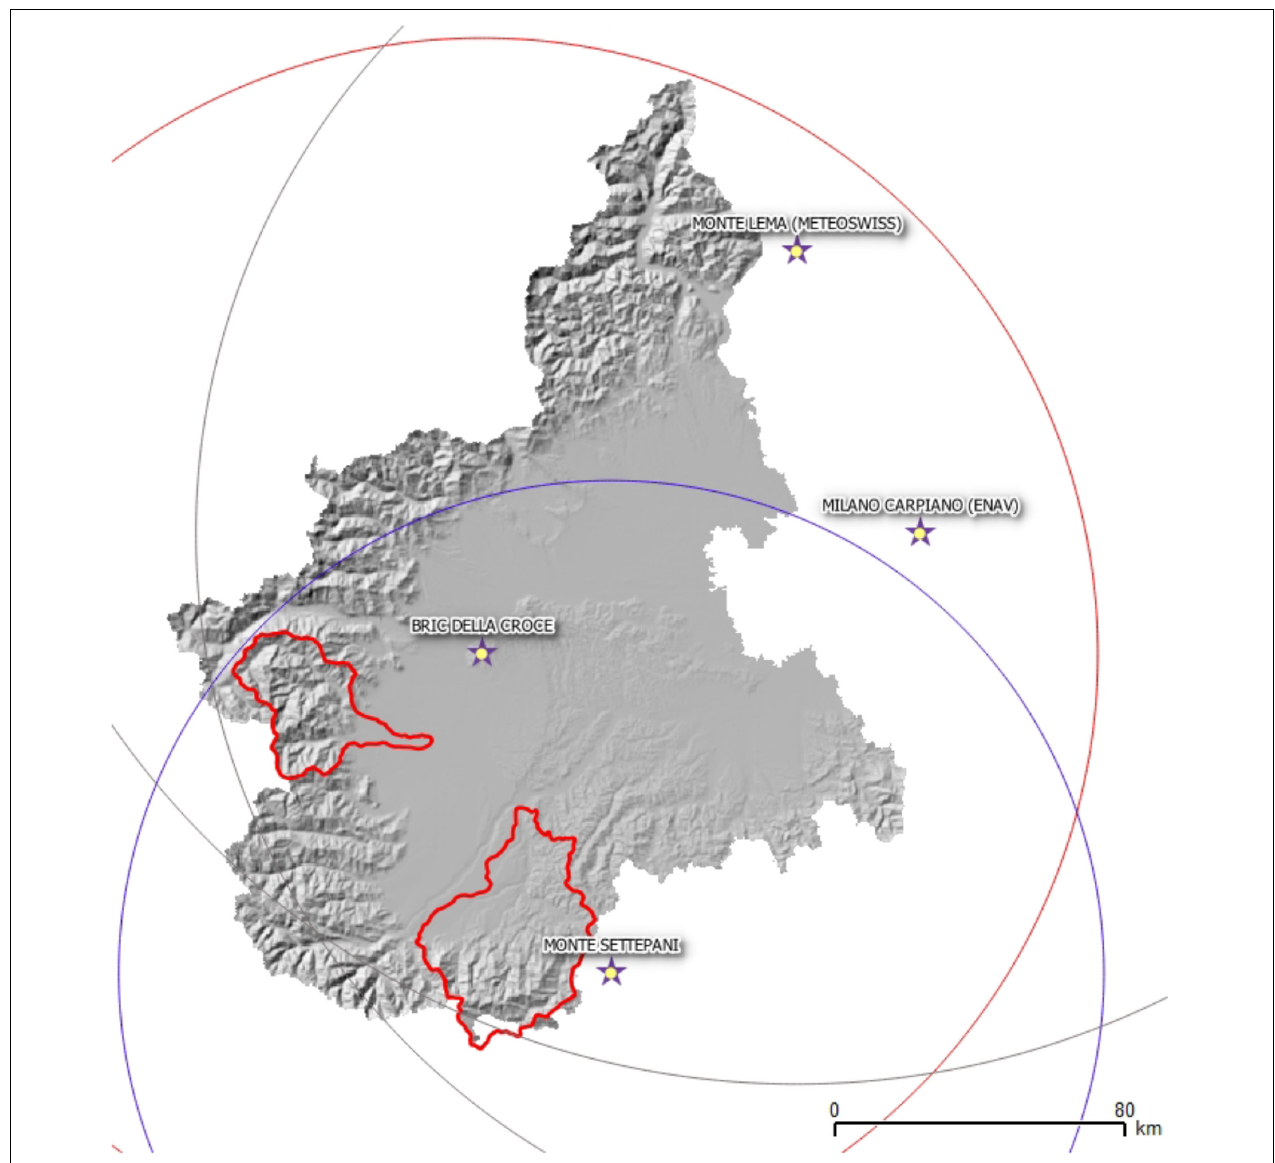
FIGURE 2 | Weather radar coverage in north-western Italy. Star symbols show weather radar sites, circles volume scans coverage, polylines the target